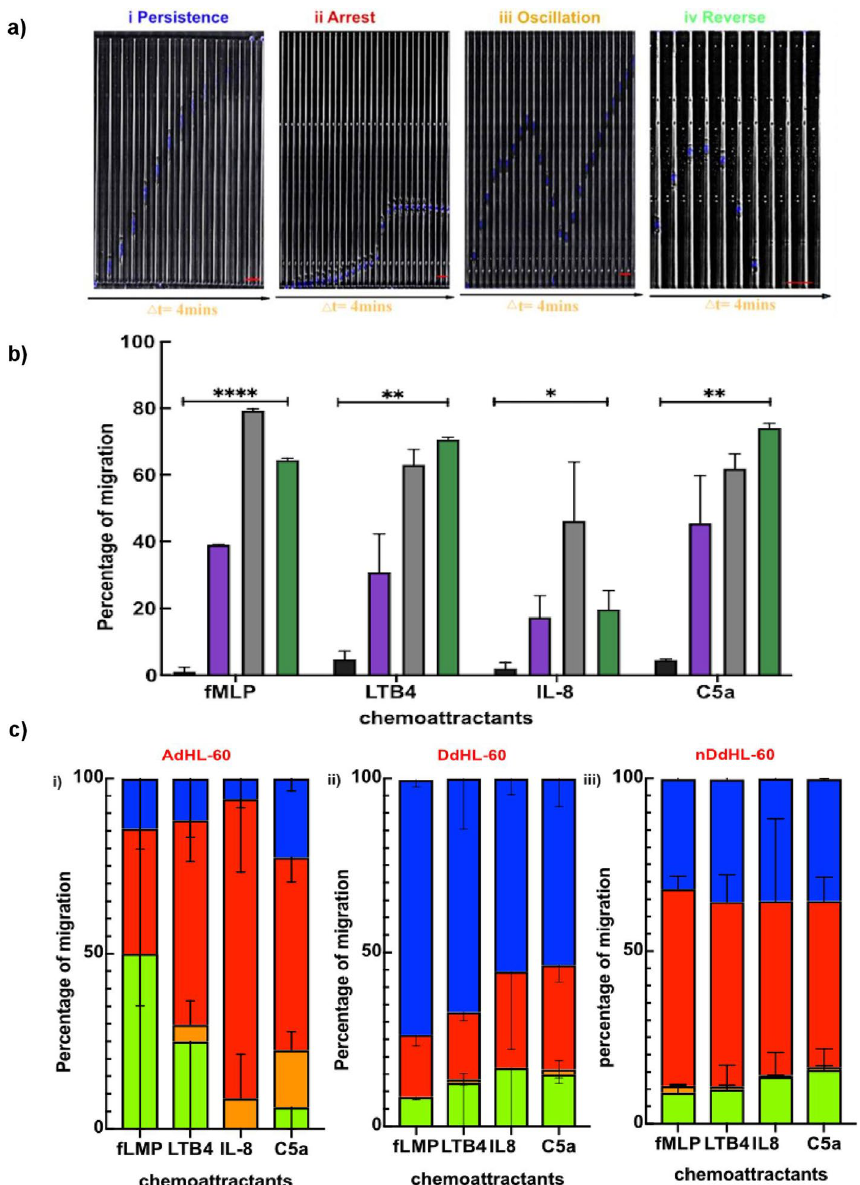
Figure 2. Migration of HL-60 cells through tapered channels after differentiation using different protocols. ( a ) Kymographs show the persistent (P), Arrest (A), Oscillation (O) and reverse (R) migration patterns. The nuclei of the HL-60 cells are stained with Hoechst dye (blue). The time interval between two consecutive frames of the kymographs is 4 min. Scale bar is 25 µm. ( b ) The percentage of migration in fMLP, LTB4, IL-8 and C5a gradients of ATRA (Black bars), DMSO (Violet bars), nDdHL-60 (Grey bars) and primary neutrophils (Green bars) toward each chemokine gradients. ( c ) Percentage of migratory patterns in (i) DdHL-60 cells, (ii) AdHL- 60 cells and (iii) nDdHL-60 cells. Persistence (Blue color), Arrest (Red color), Oscillation (Orange color) and Retrotaxis (Green color). Comparison between the percentage of migration towards each chemo-attractants were performed by one-way ANOVA; **** P < 0.0001 in fMLP, ** P < 0.01 in LTB4 and C5a and * P < 0.05 in